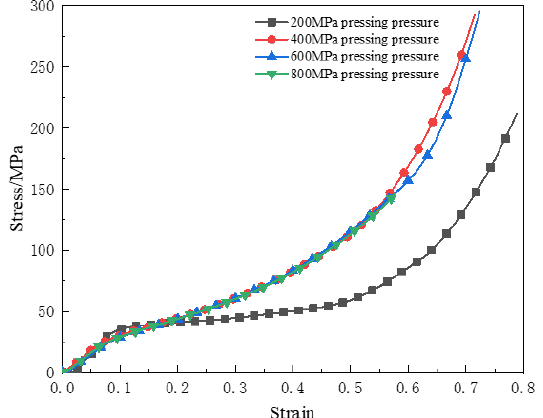
Figure 3. Quasi–static compressive stress–strain curves of different pressing pressures.